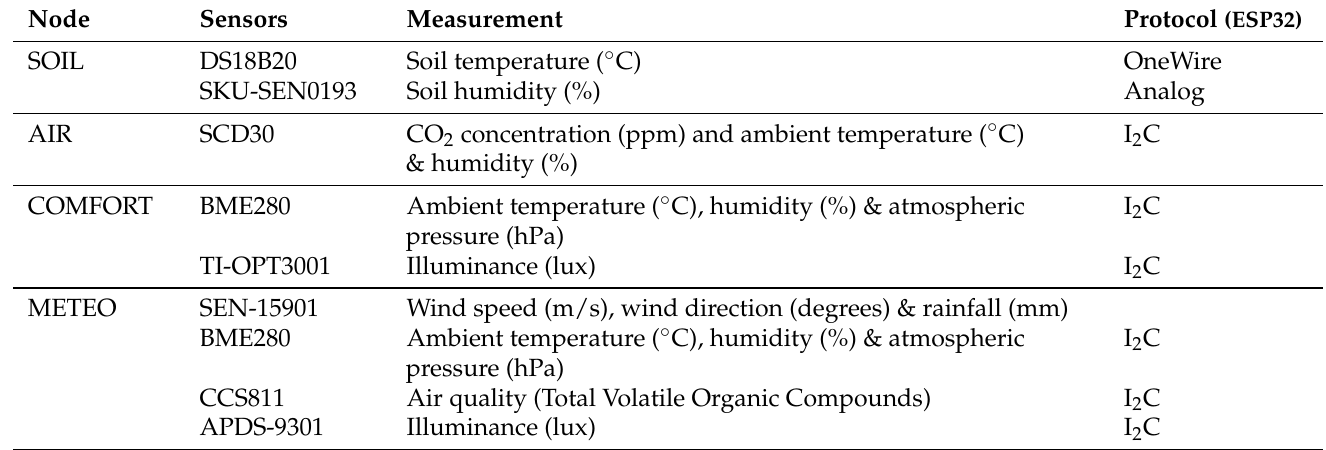
Table 1. Sensing nodes for the measurement of the different ambient variables and associated sensors and interfaces. Node Sensors Measurement Protocol